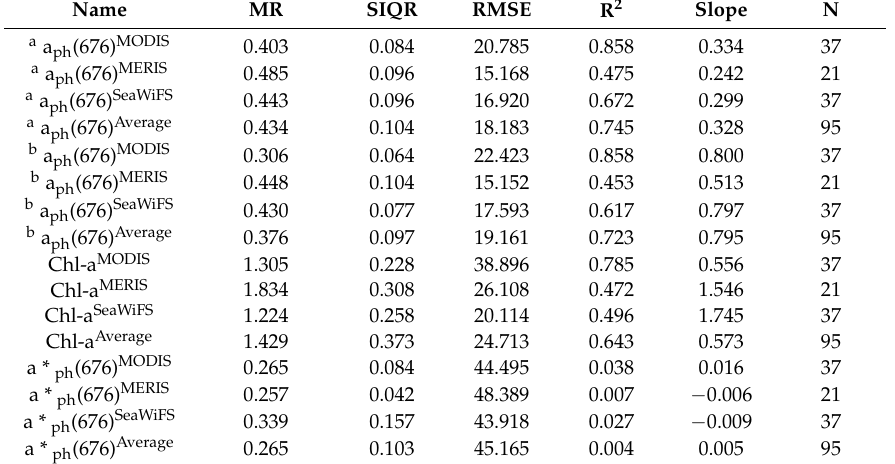
Table 7. Statistical results for the validation of abundance-based algorithms for MERIS, MODIS and SeaWiFS. The slope is the linear regression results from retrievals versus in situ ones. N is the number of samples.